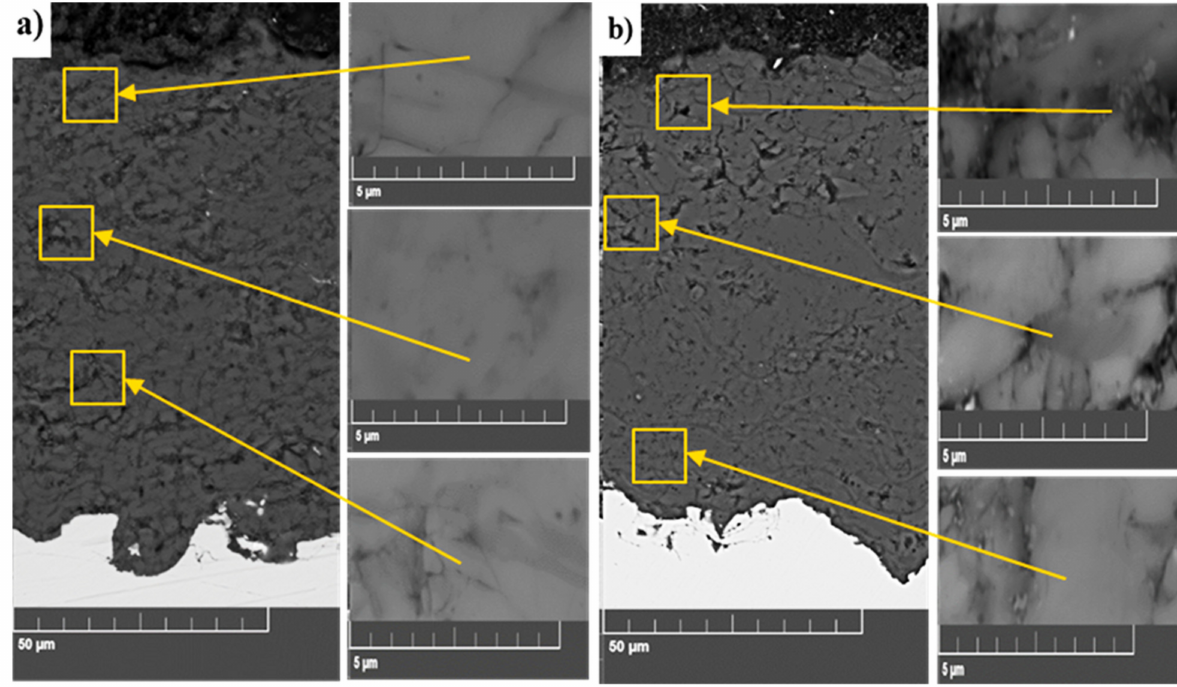
Figure 8. SEM image of the cross section of the coating A90-P0 ( a ) and A 80P10 ( b